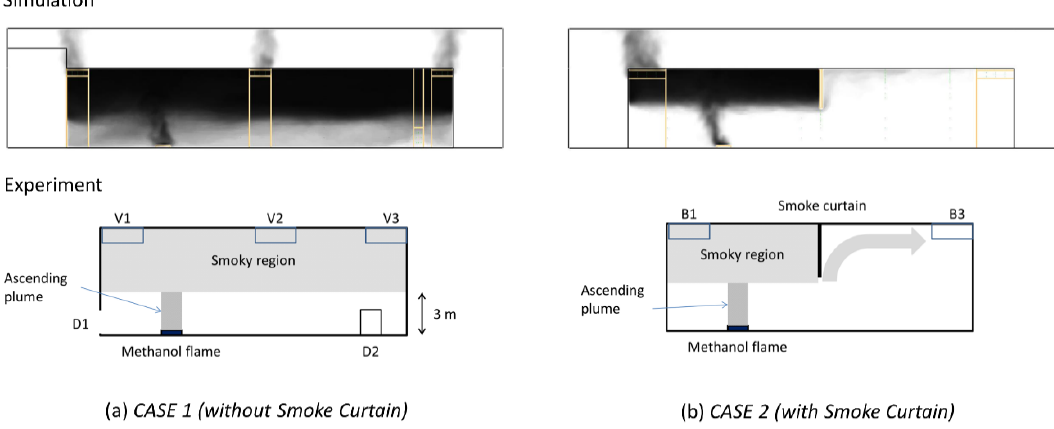
Figure 8. Smoke Comparison between the numerical simulation and the experimental observations from Hägglund and Niresus [39] for ( a ) Case 1 and ( b ) Case 2 .